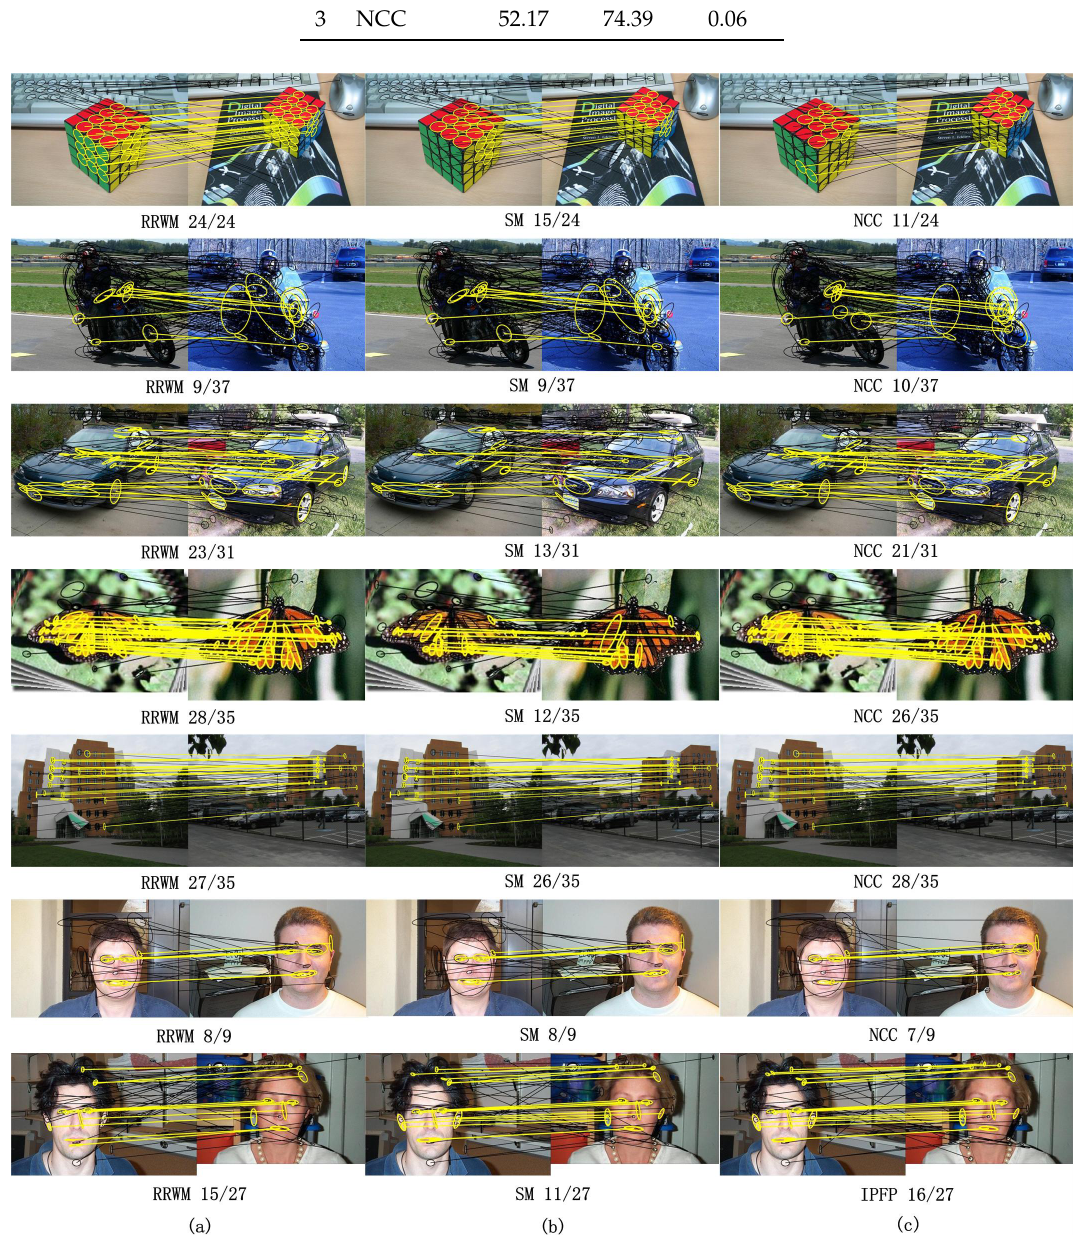
Figure 13. From the left to the right: ( a ) RRWM algorithm, ( b ) SM algorithm, and ( c ) NCC algorithm for graph matching. (The yellow lines represent the correct matching pairs, and the black lines represent the wrong